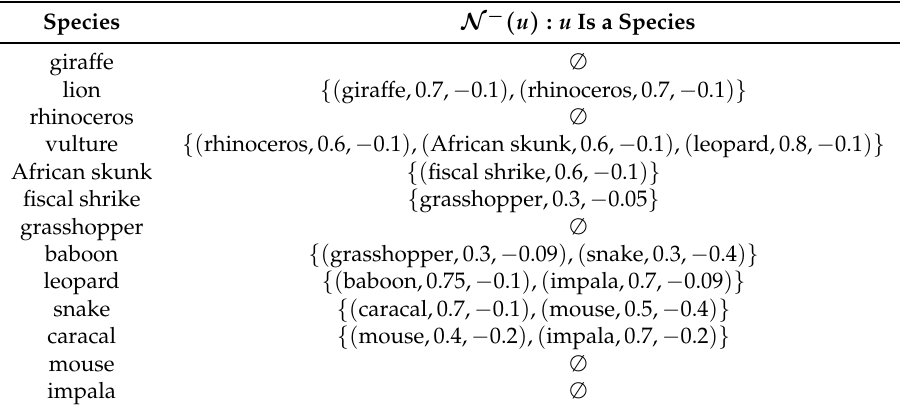
Table 3. The bipolar fuzzy in